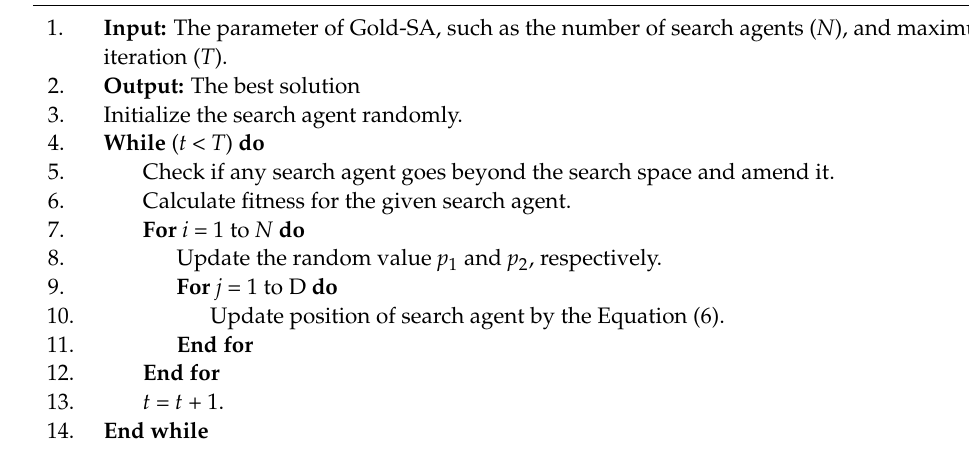
Algorithm 2 pseudo-code of Gold-SA [27]